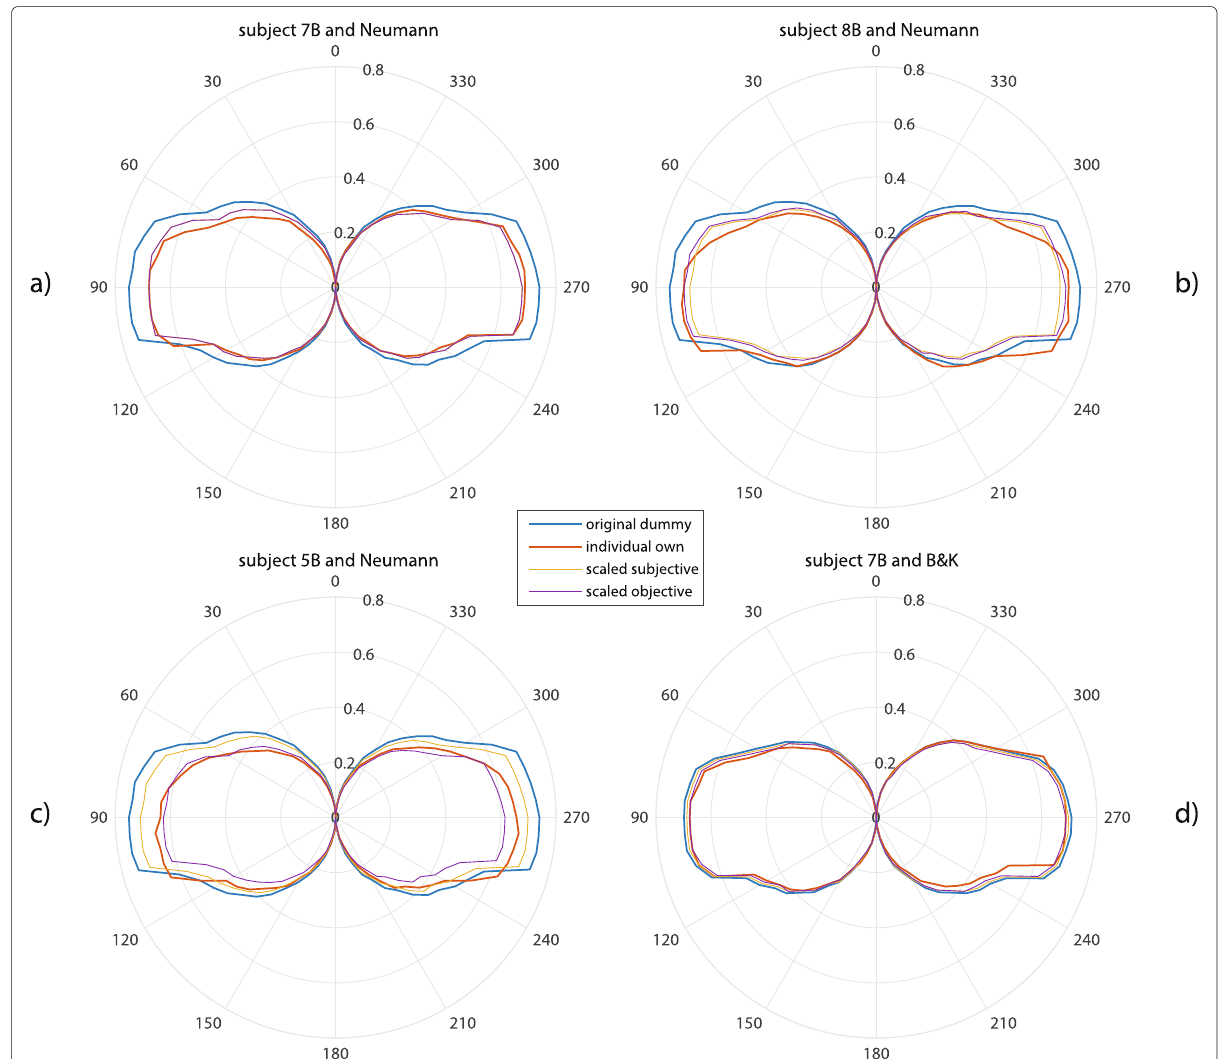
Fig. 9 Four selected examples of validation measurements with scaled ITD. Radial units are in ms. a Excellent adjustment and coincident for both subjective and objective criteria (MSE 31.21). b good adjustment for subjectivecriterion (MSE 252.69) and very good adjustment for objectivecriterion (MSE 55.00). c Bad adjustment for both subjective (MSE 937.92) and objective criteria (MSE 533.62). d Very good adjustment and nearly coincident for both subjective (MSE 160.53) and objective criteria (MSE